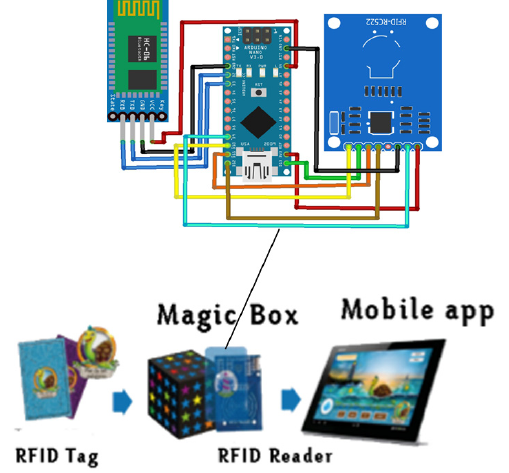
Figure 6. Interaction phono-cards with RFID + Tablet.